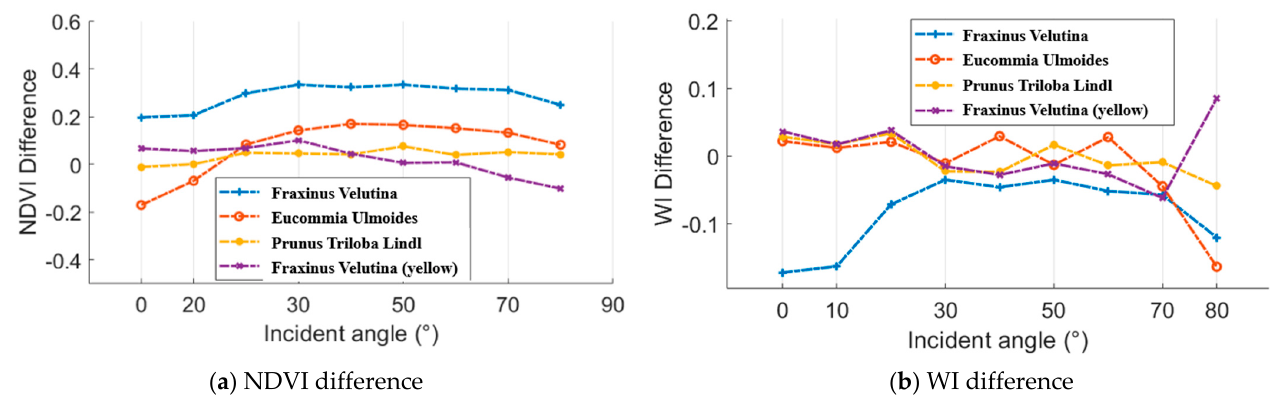
Figure 15. NDVI and WI results.